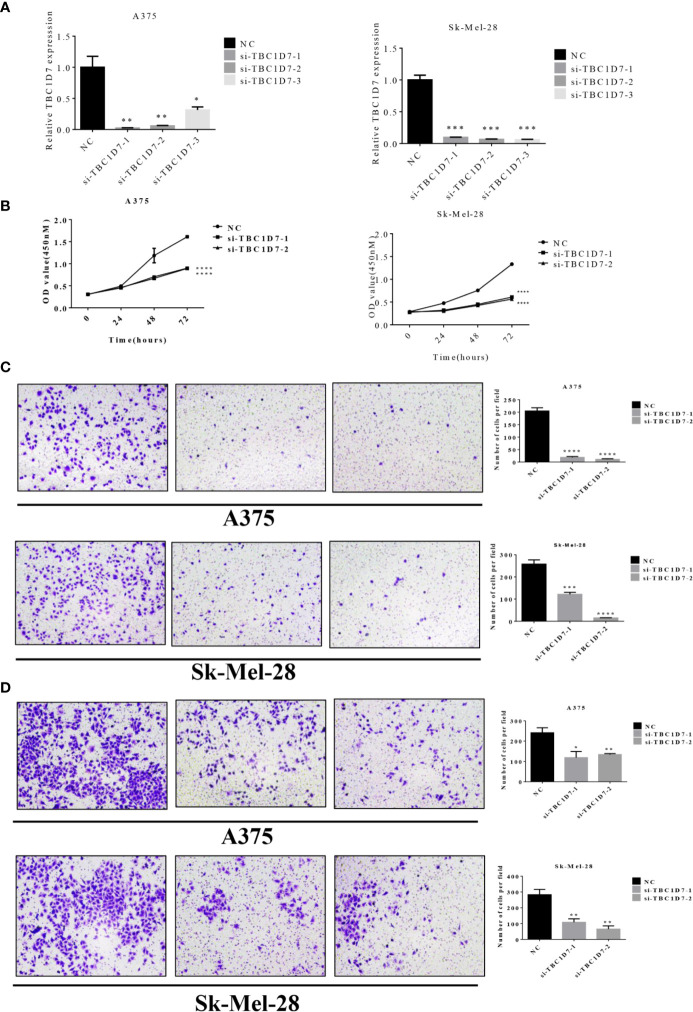
Interference of TBC1D7 expression inhibits melanoma cell migration and invasion. (A) The relative mRNA levels of TBC1D7 at 36 h after transfection with si-TBC1D7-1, si-TBC1D7-2, si-TBC1D7-3 and NC as control in melanoma cells A375 and Sk-Mel-28 were measured by RT-PCR. GAPDH was used as a control. *p <, **p < 0.01, ***p < 0.001. (B) Melanoma cells A375 and Sk-Mel-28 interfered with si-TBC1D7, 2.0 x 103 cells planted into 96-well cultured for 24, 48, 72 h, CCK-8 kits were used to detect the proliferation at OD450nM following the manufacturer’s instruction. Each group have 5 replicates(n=5) with 3 independent experiments. ****p < 0.0001. (C) A number of 1 x 104 cells were seeded into the upper chambers with 550ul medium containing 30% FBS put into the lower chambers. Chambers after cultured for 24 h were fixed with 4% paraformaldehyde, stained with crystal violet and imaged by microscope. Representative images of migration of A375 and Sk-Mel-28, the numbers of magration cells per field were calculated, and the results are presented as the mean ± SD (n = 3). ***p < 0.001, ****p < 0.0001. (D) 5 x 104 cells were seeded in the chambers embed with matrigel cultured for 30 h and performed as material and methods. Representative images of invasion of A375 and Sk-Mel-28, the numbers of invasion cells per field were also calculated. *p < 0.05, **p < 0.01.